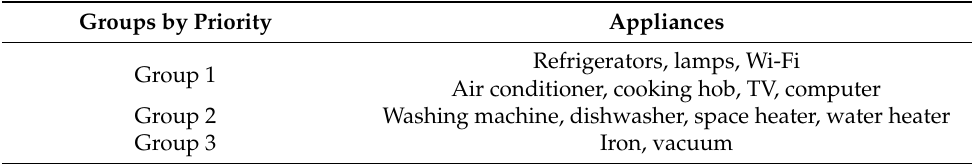
Table 2. Priorities of use of the home